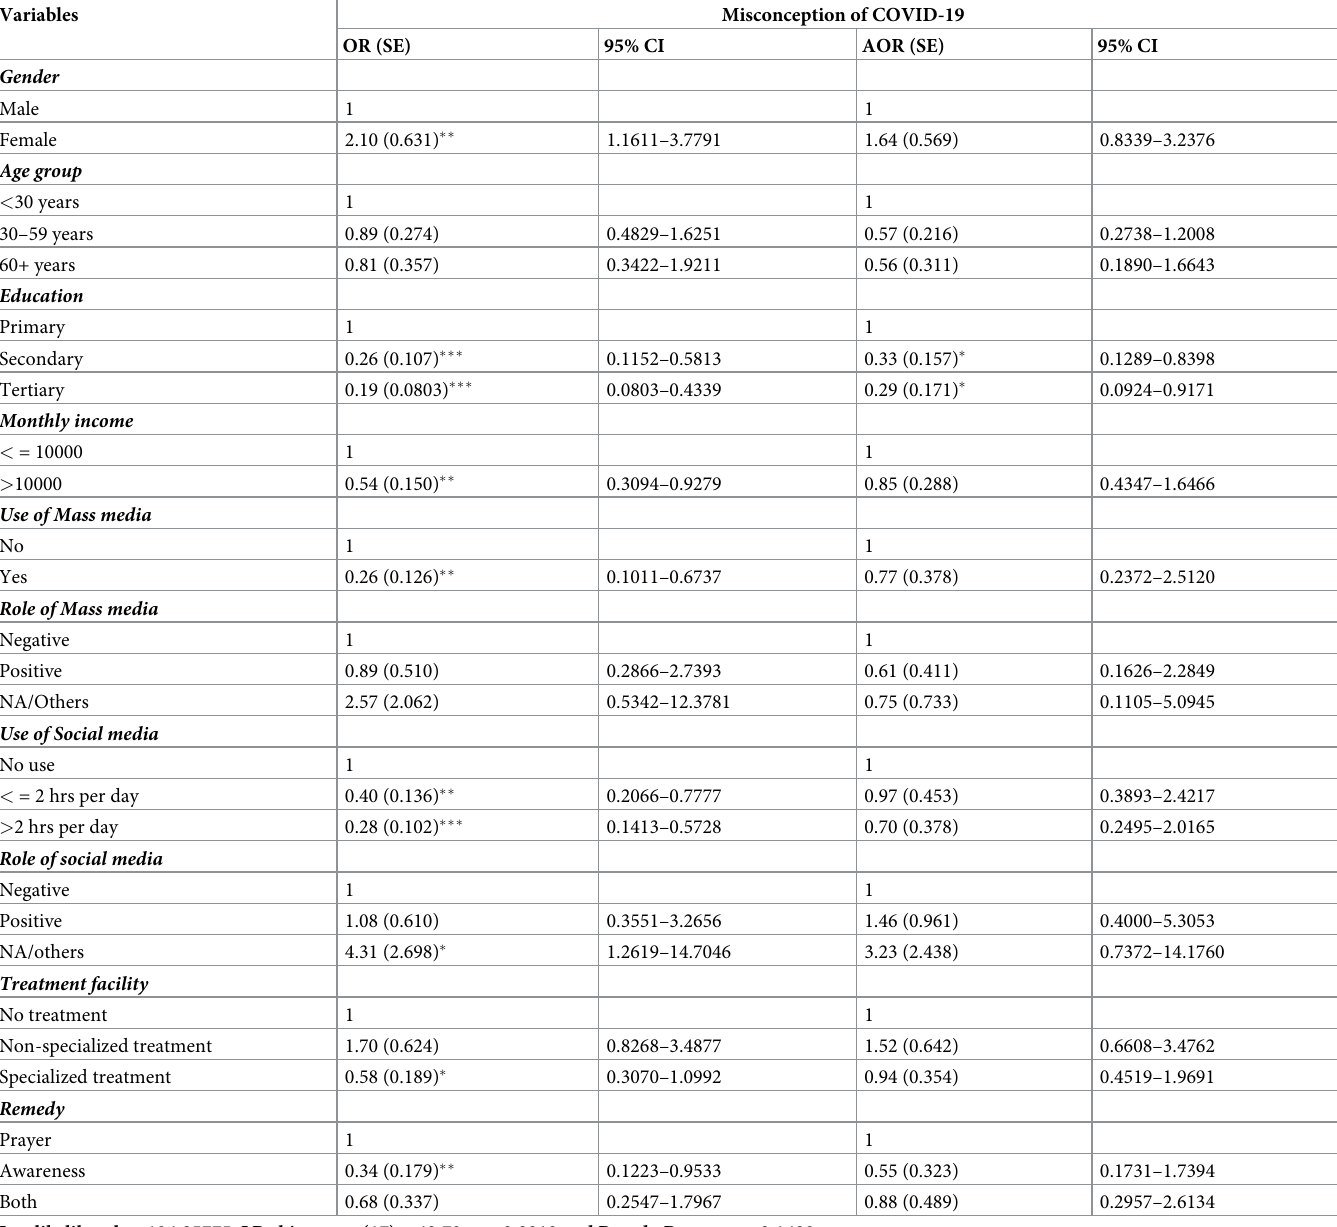
Table 4. Factors associated with the misconception about COVID-19, Satkhira district- Bangladesh, 2020.